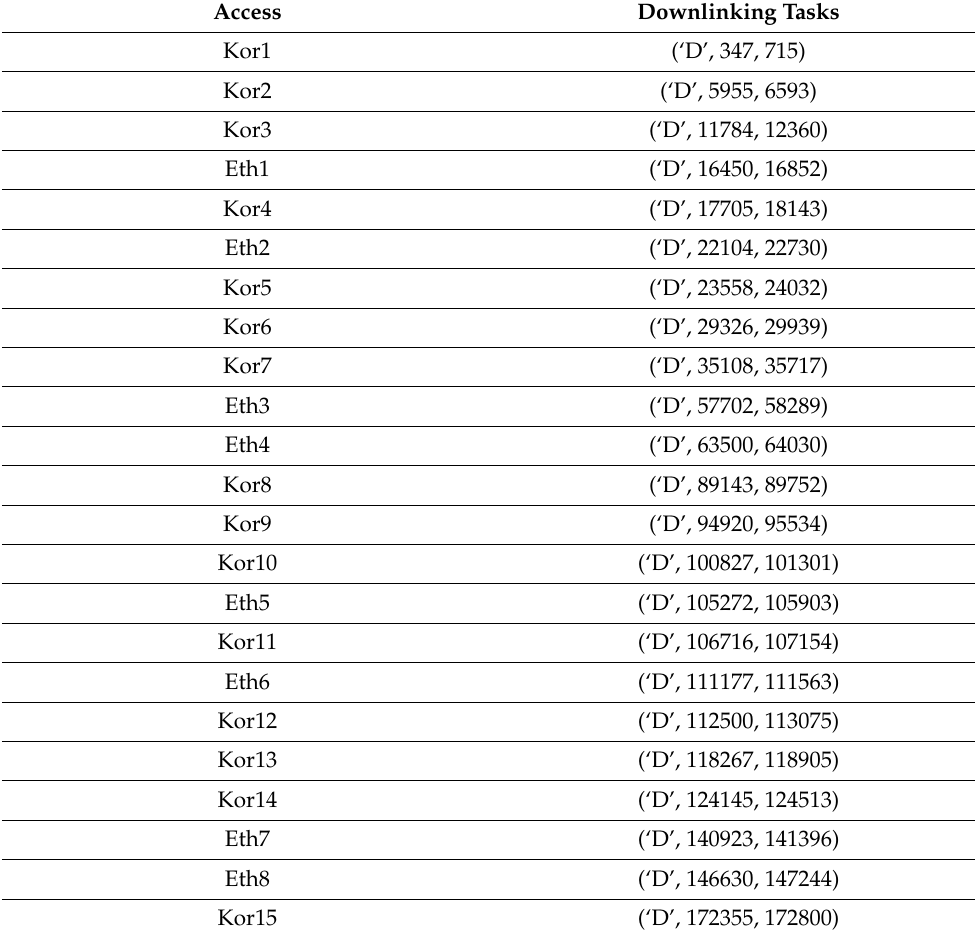
Table 4. List of Downlinking Tasks.